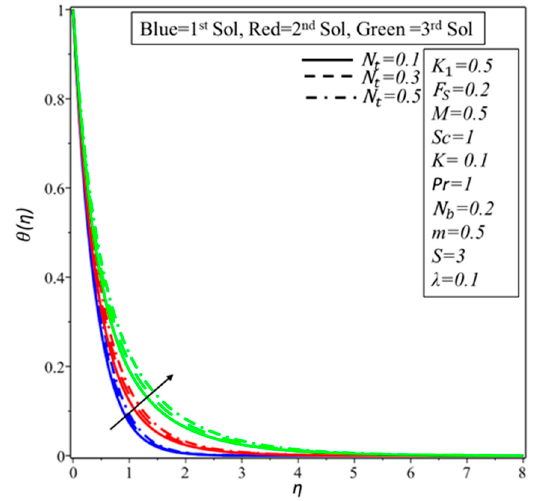
Figure 12. Temperature profiles for increasing values of N t .